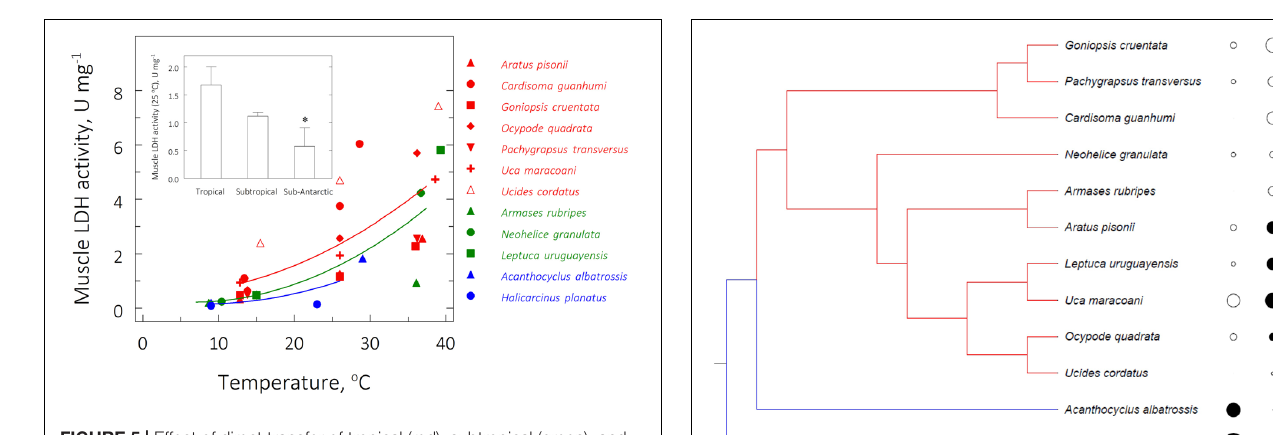
FIGURE 5 | Effect of direct transfer of tropical (red), subtropical (green), and sub-Antarctic (blue) crab species on muscle lactate dehydrogenase (LDH) activity (V max , U mg − 1 ) after 6 h exposure to their respective upper and lower critical thermal limits from their corresponding field reference temperatures (FRT) of 26, 15, and 9 ◦ C. Data are mean values (2 ≤ N ≤ 3, pools of 3 individuals each) and were adjusted to a second degree polynomial curve. V max was measured continuously in duplicate aliquots at the same experimental temperatures. Activities could not be measured for the sub-Antarctic species at their lower critical thermal limits. Insert : Mean ( ± SEM) muscle LDH activity at 25 ◦ C for all species from each province (2 ≤ N ≤ 3, pools of 3 individuals each); muscle samples taken at the FRT of each species. *Significantly different from tropical crab species (phyHolm-Bonferroni, P ≤ 0.05).